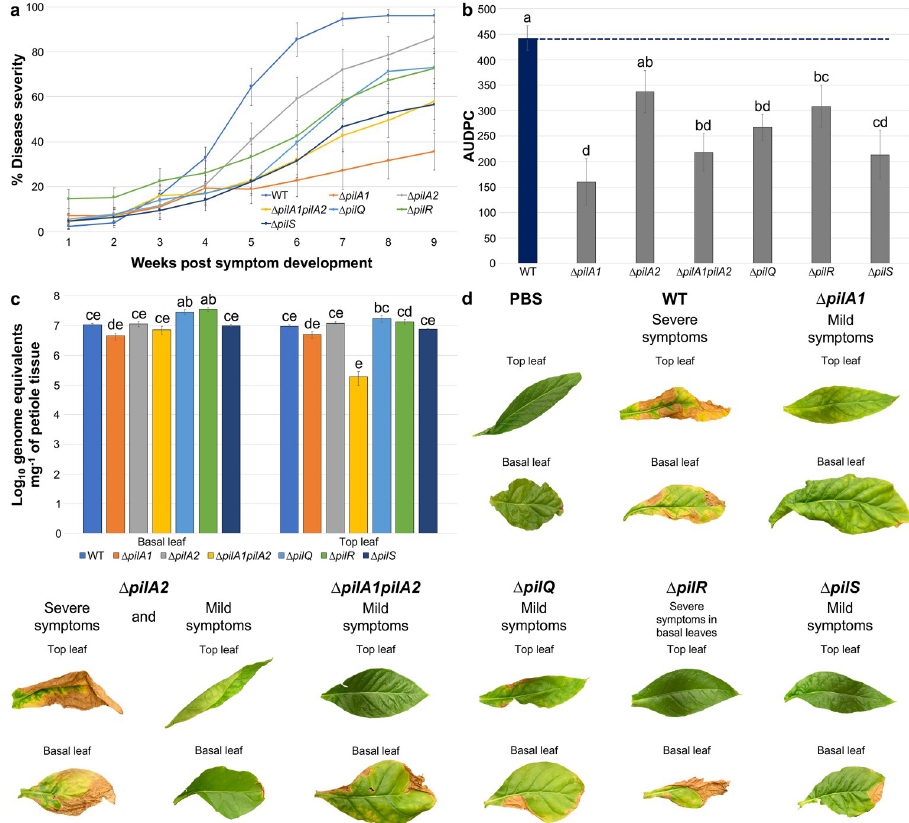
Fig 2. Deletion of pil genes negatively affects virulence of X . fastidiosa . a Disease severity progression over time in inoculated tobacco plants. X . fastidiosa WT and mutant strains were inoculated into Nicotiana tabacum L. cv. Petite Havana SR1 plants (PBS mock inoculation used as control). Mutant strains chosen for inoculation presented different twitching motility phenotypes, including higher twitching motility ( Δ pilA1 and Δ pilS ), lower twitching motility ( Δ pilA2 ) and non-motility ( Δ pilA1pilA2 , Δ pilQ and Δ pilR ). Leaf scorch symptoms were recorded for measurements of disease incidence and severity once a week during nine weeks after appearance of the first disease symptoms. At the final time point of evaluation, disease incidence in all inoculated plants reached 100%, except for plants inoculated with Δ pilA1 , which reached 88.88% disease incidence ( ± 11.11%, standard error). On the other hand, disease severity reached 96% in the WT, 35% in Δ pilA1 , 86% in Δ pilA2 , 57% in Δ pilA1pilA2 , 73% in Δ pilQ , 72% in Δ pilR and 56% in Δ pilS . Data represent means and standard errors from two independent experiments (n = seven to ten plants in each independent experiment). b Mean AUDPC per treatment group. AUDPC was calculated using data from disease severity over nine weeks after first disease symptom appearance. WT is highlighted in blue, and the dashed blue line indicates the mean value of AUDPC for WT-inoculated plants. AUDPC was significantly lower for plants inoculated with all mutant strains in comparison to WT-inoculated plants, except for Δ pilA2 . Data represent means and standard errors. Different letters on top of bars indicate significant difference as analyzed by ANOVA followed by Tukey’s HSD multiple comparisons of means ( P < 0.05; n = two independent experiments with seven to ten plants each). c X . fastidiosa in planta population determined by qPCR at the last time point of evaluation. The population of WT and mutant strains throughout inoculated plants was calculated using petioles of basal and top leaves. Δ pilA1pilA2 cells showed a defect in colonizing the top leaf of plant hosts, while Δ pilQ and Δ pilR showed a significant higher population in the basal leaf of infected plants. This shows that mutant strains still move inside the xylem of plant hosts, but absence of deleted genes impairs full symptom development. Data represent means and standard errors. Different letters on top of bars indicate significant difference as analyzed by ANOVA followed by Tukey’s HSD multiple comparisons of means ( P < 0.05; n = two independent experiments with three leaf replicates each). d Figure panel with representative pictures of leaf scorch symptoms in WT- and mutant strains-inoculated plants (top and basal leaves), as well as control plants (PBS mock inoculation). Only WT-inoculated plants consistently presented severe leaf scorch symptoms. Similar events were captured in two independent